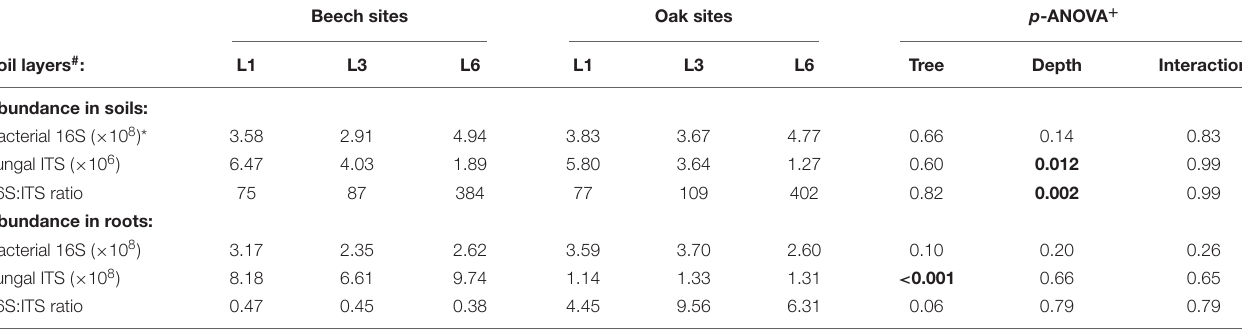
TABLE 4 | Mean values of bacterial and fungal abundances (16S and ITS copy numbers) and the bacteria to fungal ratio in bulk soils and fine roots ( n = 3 forest sites). Beech sites Oak sites p -ANOVA + Tree Depth Interaction